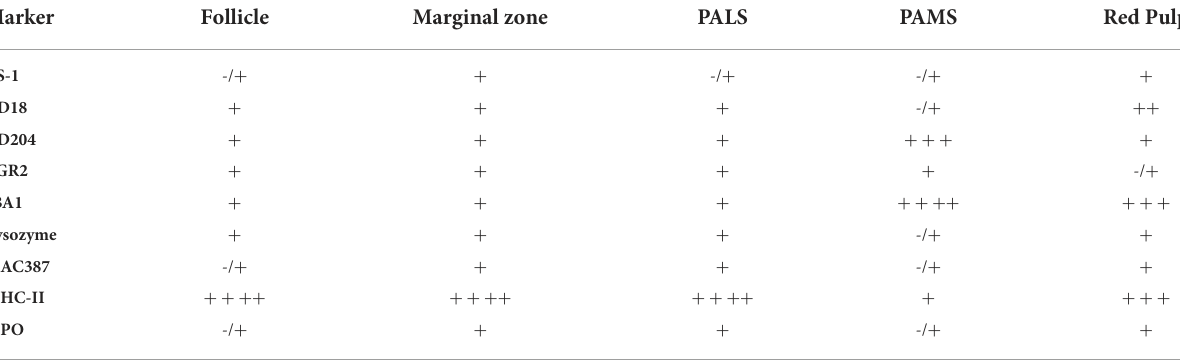
TABLE 3 Marker expression within follicles, marginal zone, the periarteriolar lymphoid sheath (PALS), the periarteriolar macrophage sheath (PAMS) and the red pulp of the canine spleen. Marker